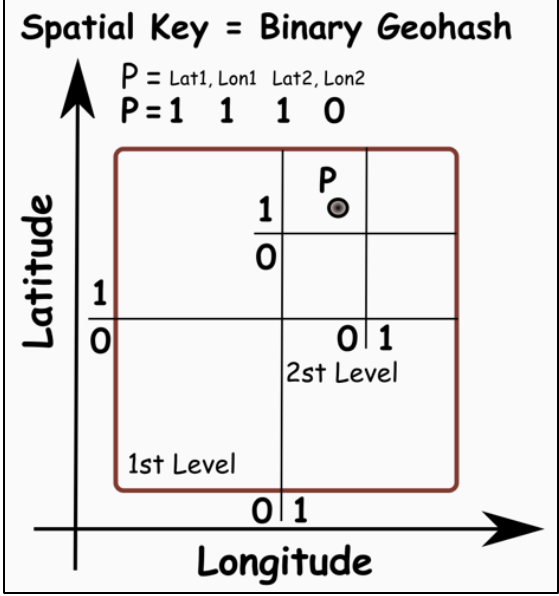
Figure 1. Binary